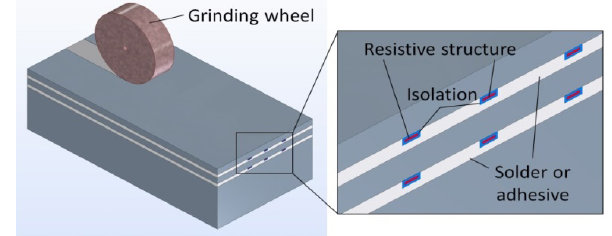
Figure 1. Schematic illustration of in situ measurement with a sensor-integrated workpiece in a surface grinding process.